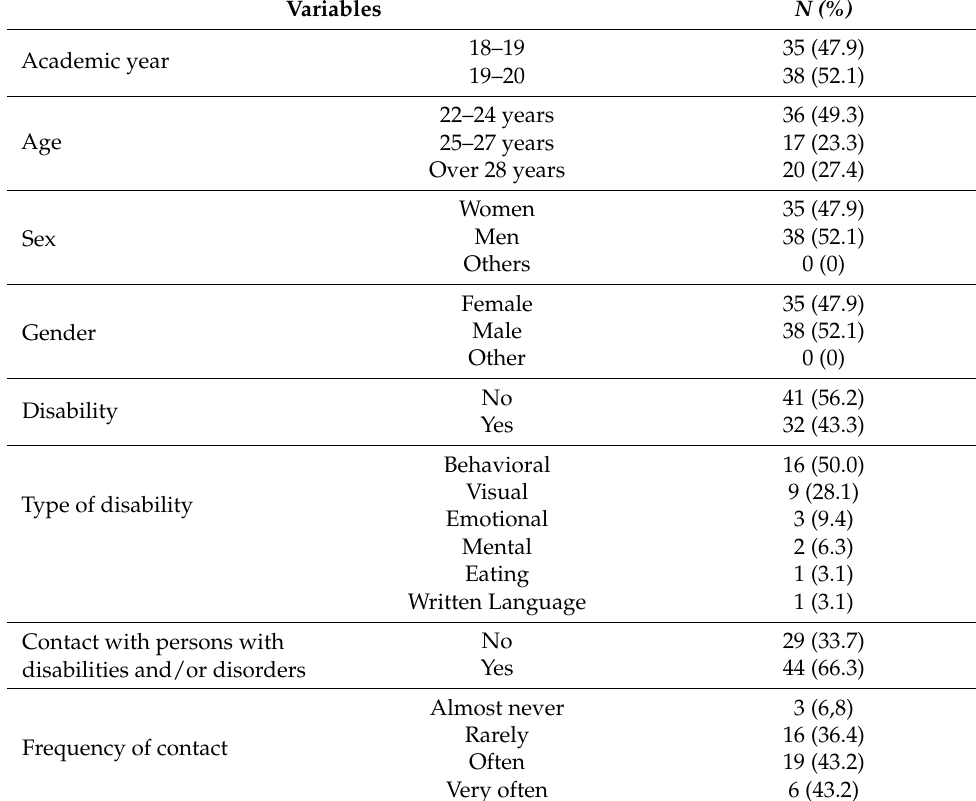
Table 1. Sociodemographic, academic and relational data of the 73 students